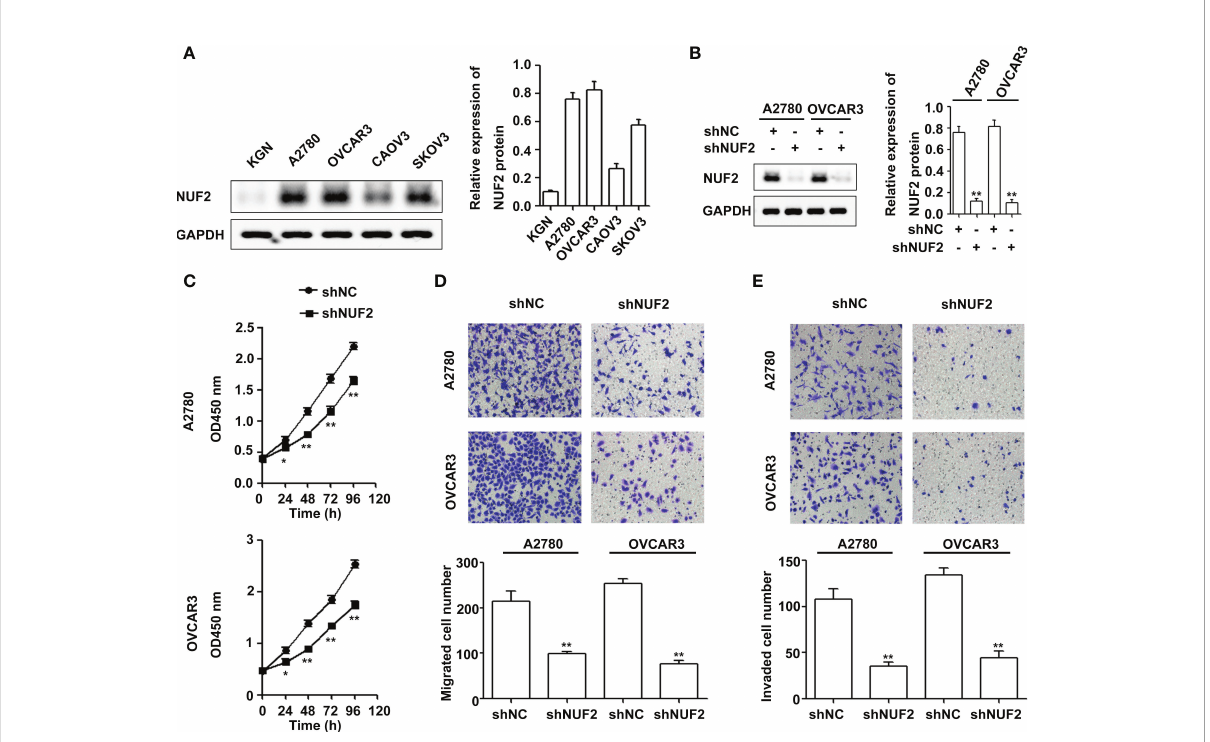
FIGURE 2 NUF2 downregulation inhibits EOC progression in vitro . (A) The protein levels of NUF2 were determined in four human EOC cell lines (A2780, OVCAR3, CAOV3 and SKOV3) and one human immortalized EOC cell line (KGN). (B) NUF2 expression in A2780 and OVCAR3 cells after transfection with shNC and shNUF2 was detected by Western blot. ** P < 0.01 vs. the shNC group. (C) A CCK-8 assay was used to determine the viability of A2780 and OVCAR3 cells after transfection with shNC and shNUF2. * P < 0.05, ** P < 0.01 vs. the shNC group. (D, E) Transwell assays were used to determine the migration and invasion of A2780 and OVCAR3 cells after transfection with shNC and shNUF2 (original magni fi cation, × 200). ** P < 0.01 vs. the shNC